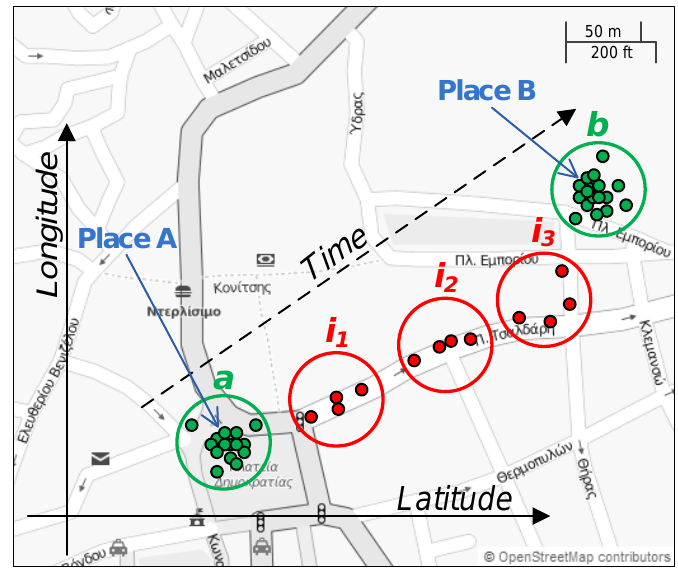
Figure 4. An illustration of the time-based clustering